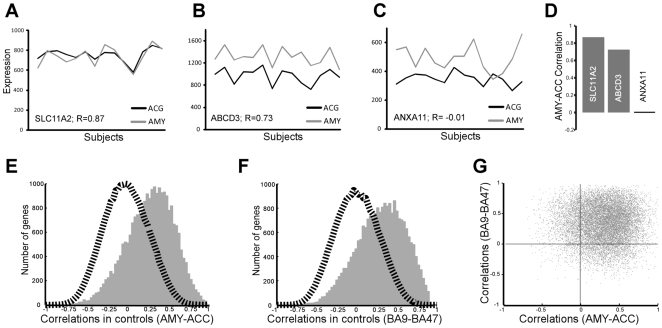
Correlated genewise transcript levels across brain regions.
A–D Examples of within-subject positive, negative and absent amygdala-cingulate gene synchrony. E The right-shifted histogram of genewise transcript correlation suggests that the majority of genes are similarly regulated in both areas. The permutated data (dashed line) is centered on zero, indicating that gene coordination is subject-specific. F A similar pattern of gene synchrony was observed between two areas of the prefrontal cortex in an independent cohort (“BA”, Brodman area). G The lack of correlations in the extent of gene synchrony between the amygdala-cingulate and prefrontal cortical areas demonstrate that different sets of genes present coordinated transcript levels in the two different sets of brain areas (G, R = 0.002). AMY, amygdala, ACC, anterior cingulate cortex.